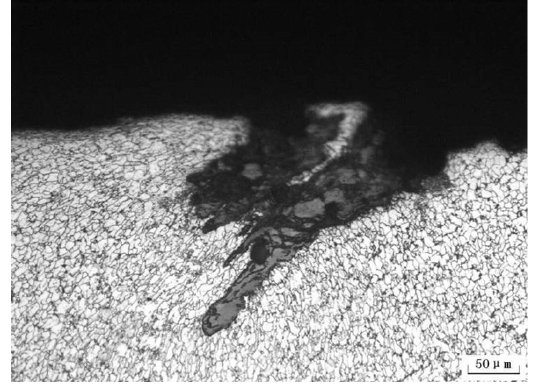
Figure 6. Small crack structures near outer surface of 2# cracking pipe.